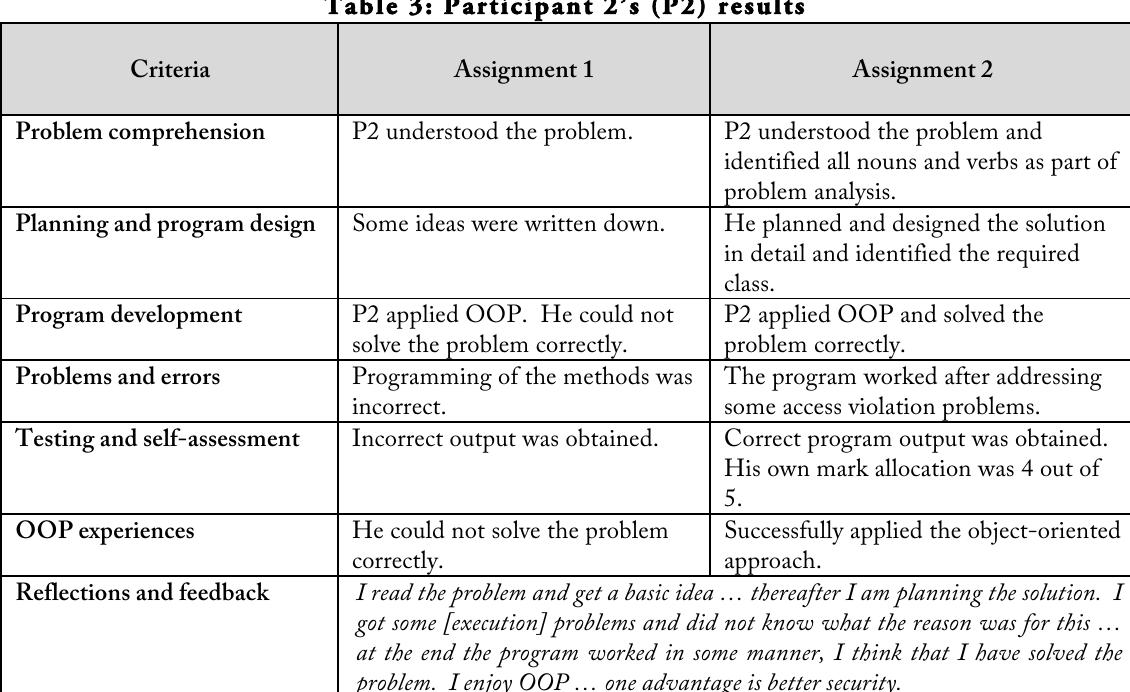
Table 3: Participant 2’s (P2)